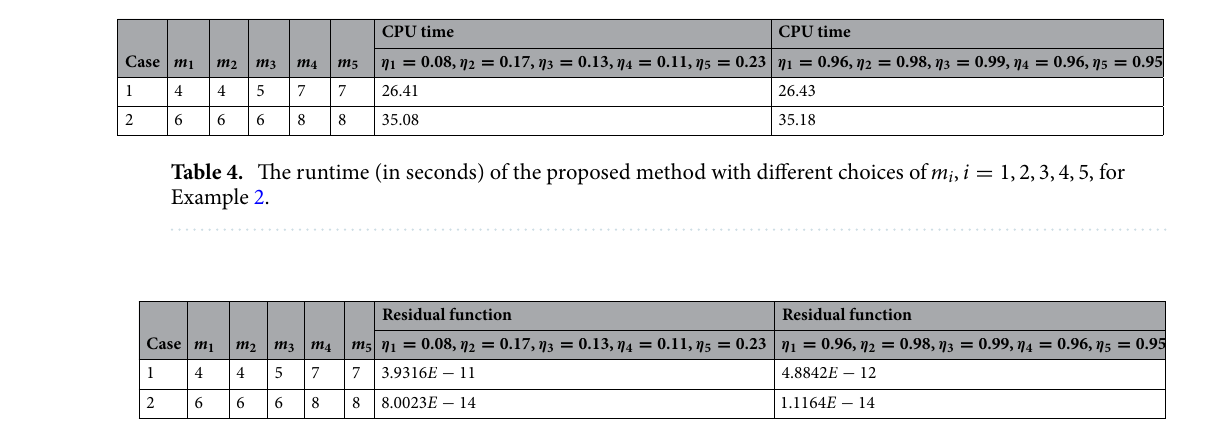
Table 5. The optimal values of the residual function with different choices of m i , i = 1, 2, 3, 4, 5 , for Example